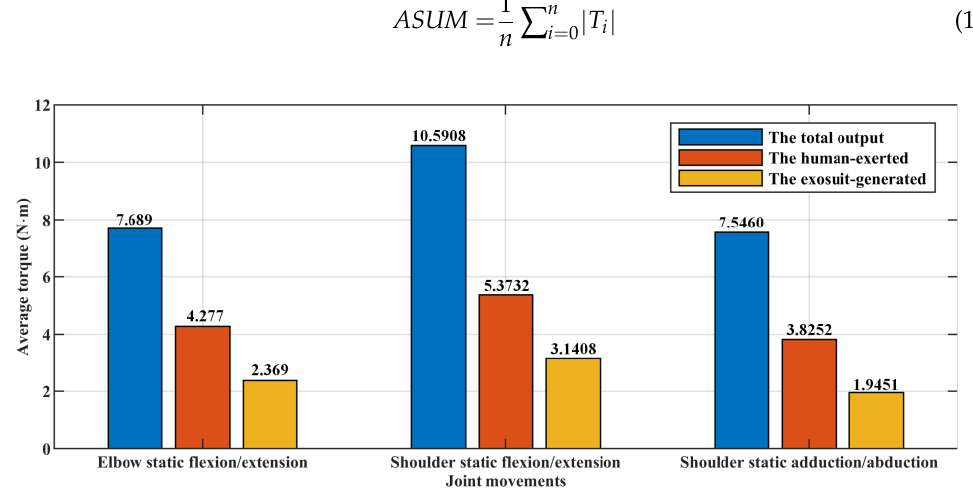
Figure 12. ASUM of different torques under each joint movement.